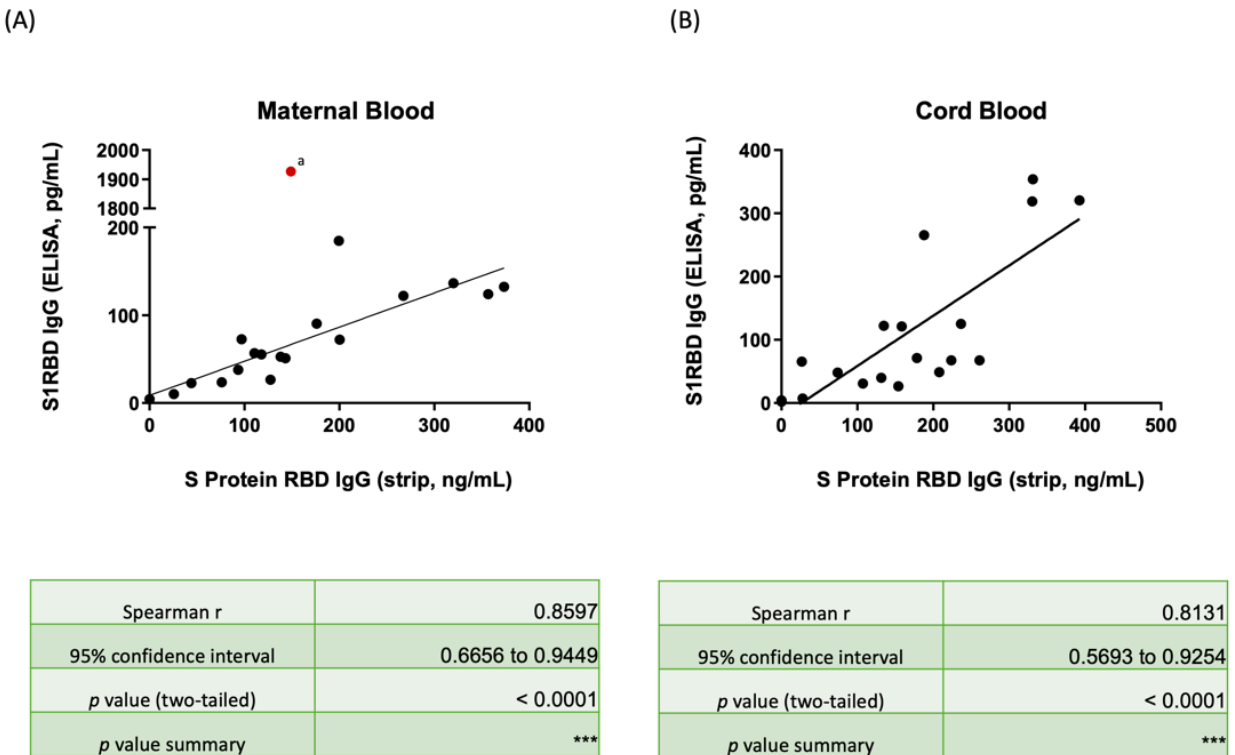
Figure 2. ( A ) Scatter plot showing the correlation between SRBD IgG by the lateral flow immunoas- say/spectrum analyzer and ELISA for maternal serum. ( B ) Scatter plot showing the correlation between SRBD IgG by the lateral flow immunoassay/spectrum analyzer and ELISA in neonatal cord blood. The red spot (a) in Table S3 was case 17 and was censored in the correlation line due to it being an outlier. SRBD, spike protein receptor binding domain; ELISA, enzyme-linked immunosorbent assay. *** p < 0.001.